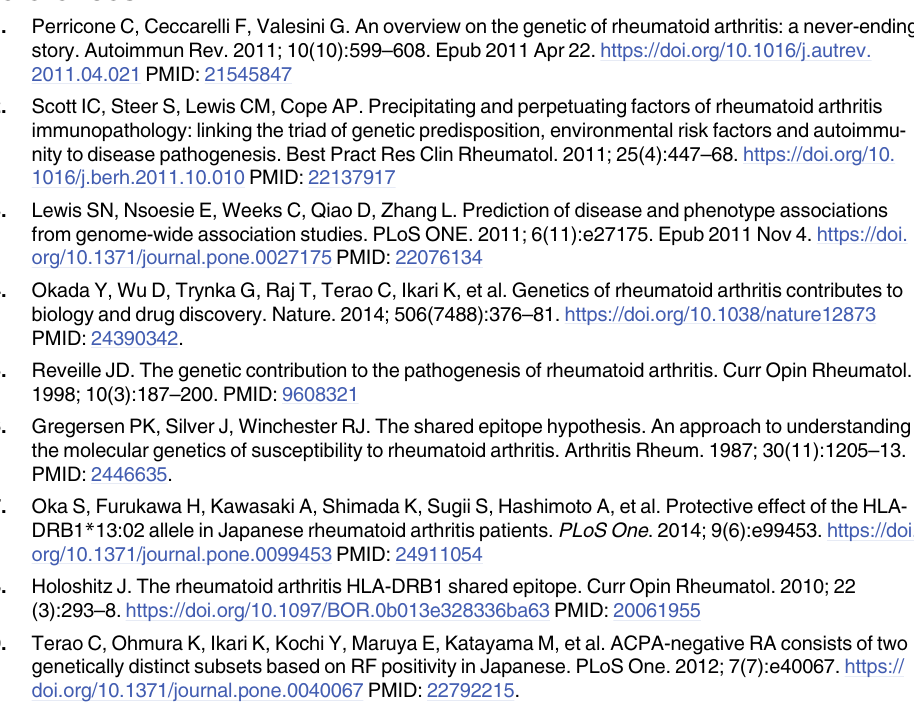
S4 Table. Conditional logistic regression analysis of HLA-DPB1 alleles in the RA patients and controls. RA: rheumatoid arthritis, OR: odds ratio, CI: confidence interval. Association was tested between the RA patients and the controls by Logistic regression analysis.